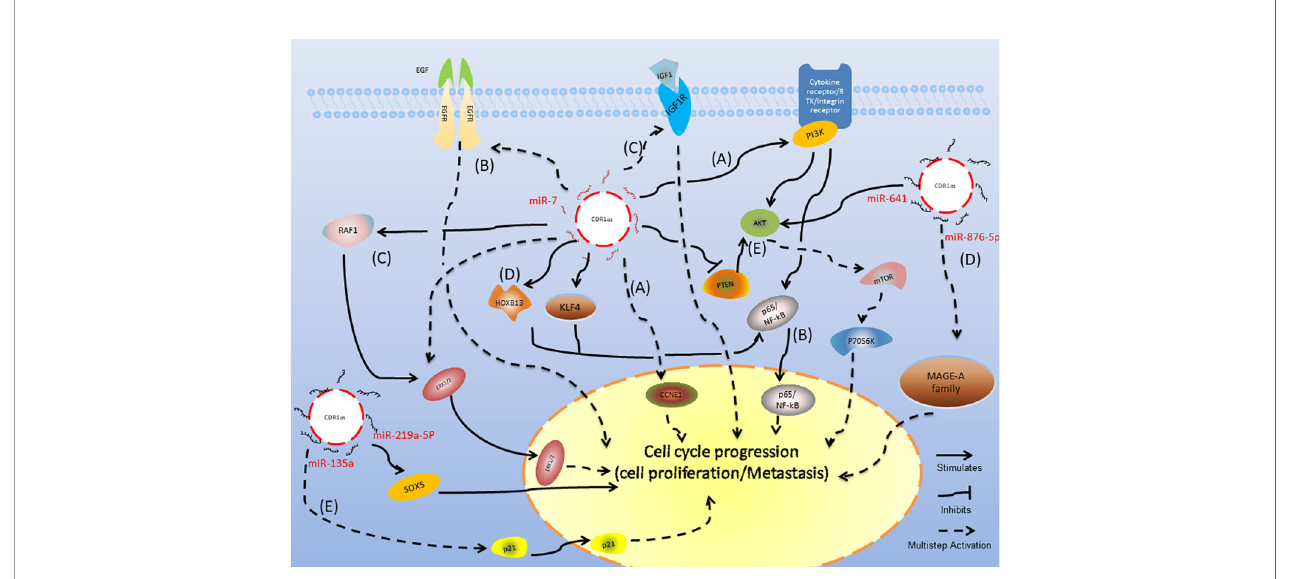
FIGURE 1 | Mechanism of CDR1as in various cancers. (A – C) CDR1as regulates the signaling pathways of HCC, NSCLC, and CRC processes. (D) CDR1as regulates the signaling pathways of ESCC processes. (E) CDR1as regulates the signaling pathways of other